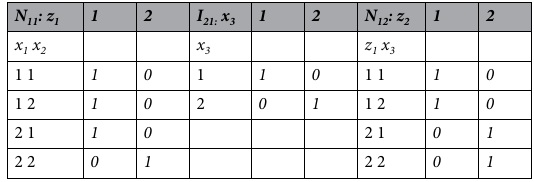
Table 1. Boolean matrices of nodes N 11 , N 12 , I 21